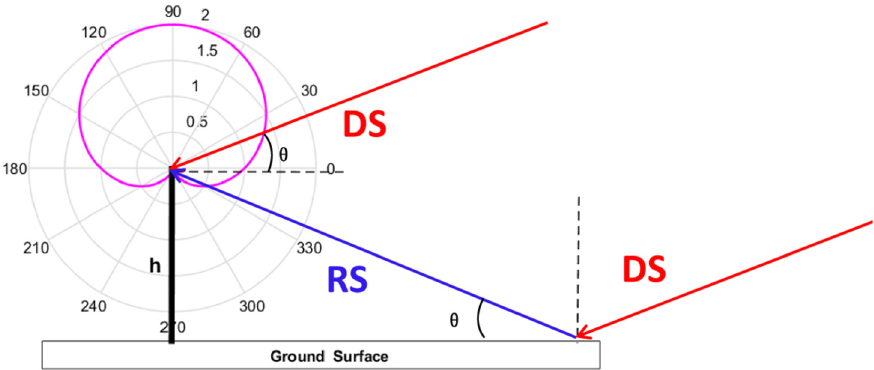
Figure 1. Scenario of Interference Generating of GNSS-IR, where θ is the elevation angle of the considered GNSS satellite, blue line represents the antenna gain pattern, and h is the antenna effective height. DS is the direct signal and RS the reflected one.